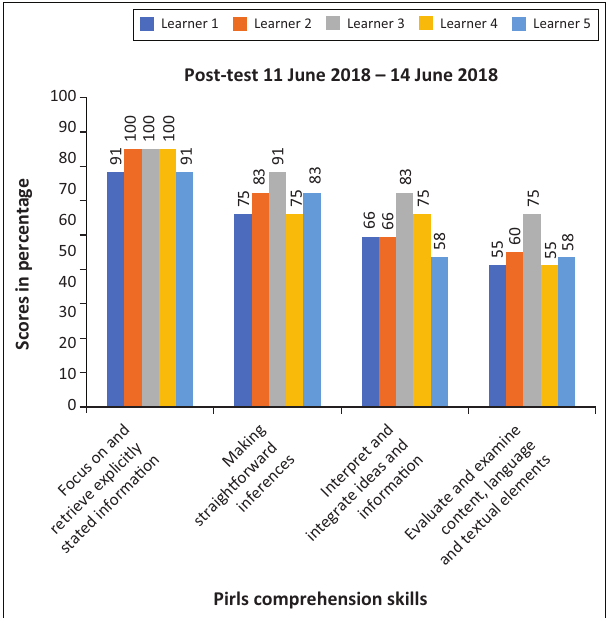
FIGURE 2: The post-test results of the five Grade 3